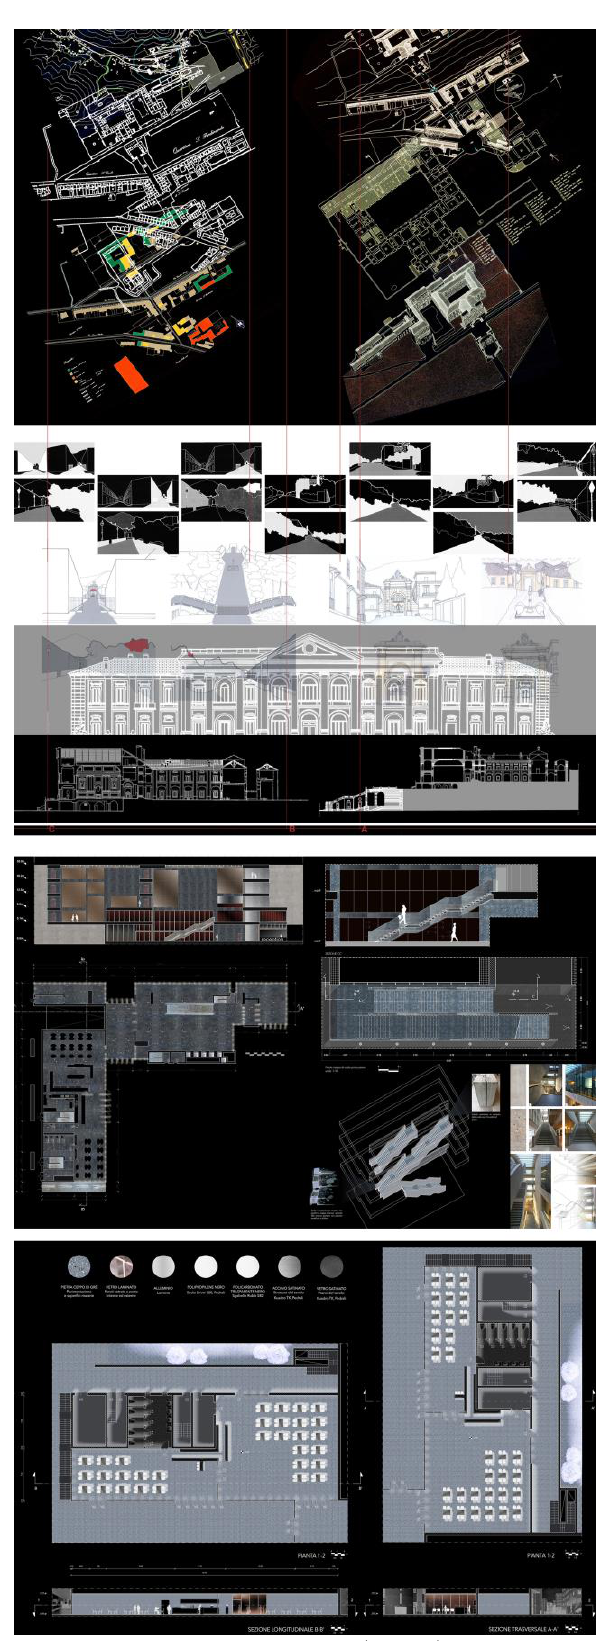
Figure 4. Belvedere di San Leucio (Caserta); New Bocconi University, Milan (2008) - Polytechnic of Milan. IMC1, Landscape Apparatus: more in-depth knowledge of the complex structure by Morphological’s Characters; Architecture Apparatus: Survey (A. De Masi).